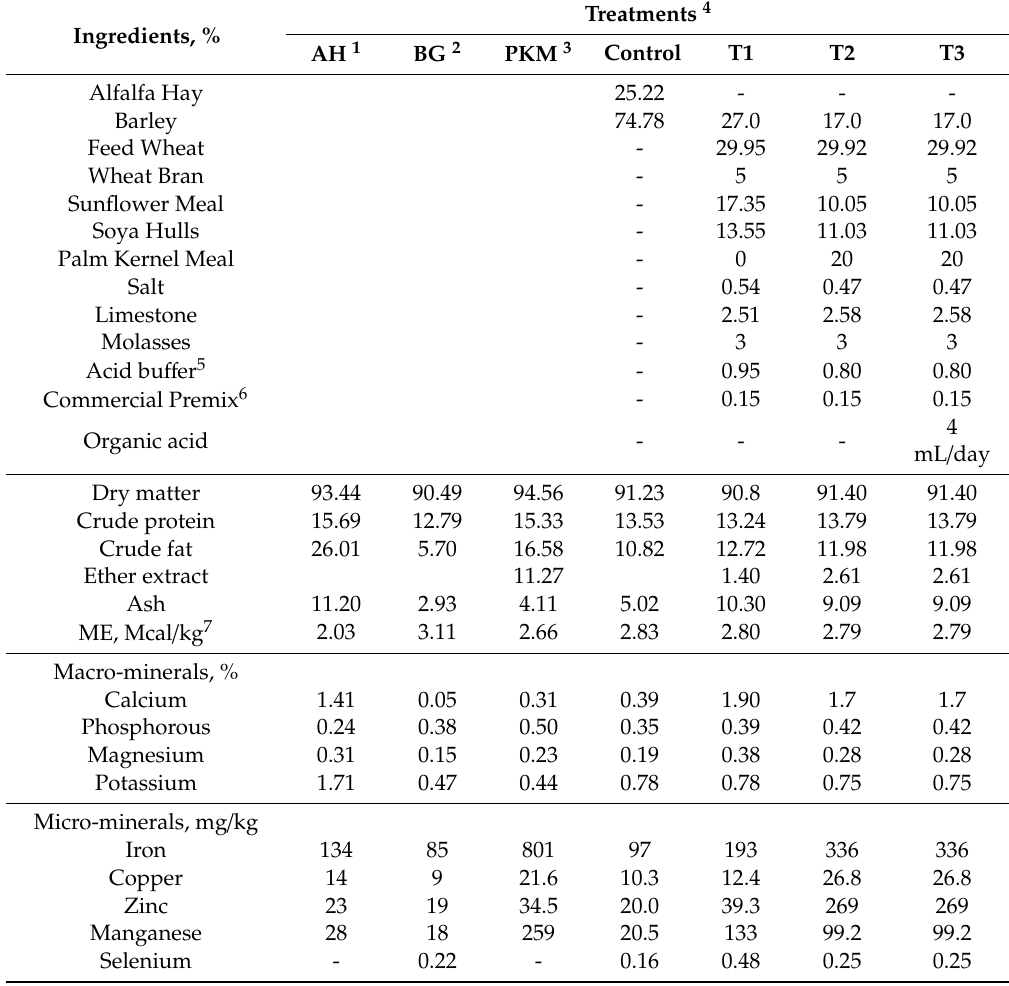
Table 1. Ingredients and chemical composition of the experimental